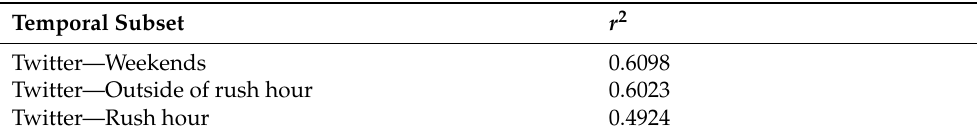
Table 7. Robustness of a two-year subset of Twitter data predicting LODES street segment